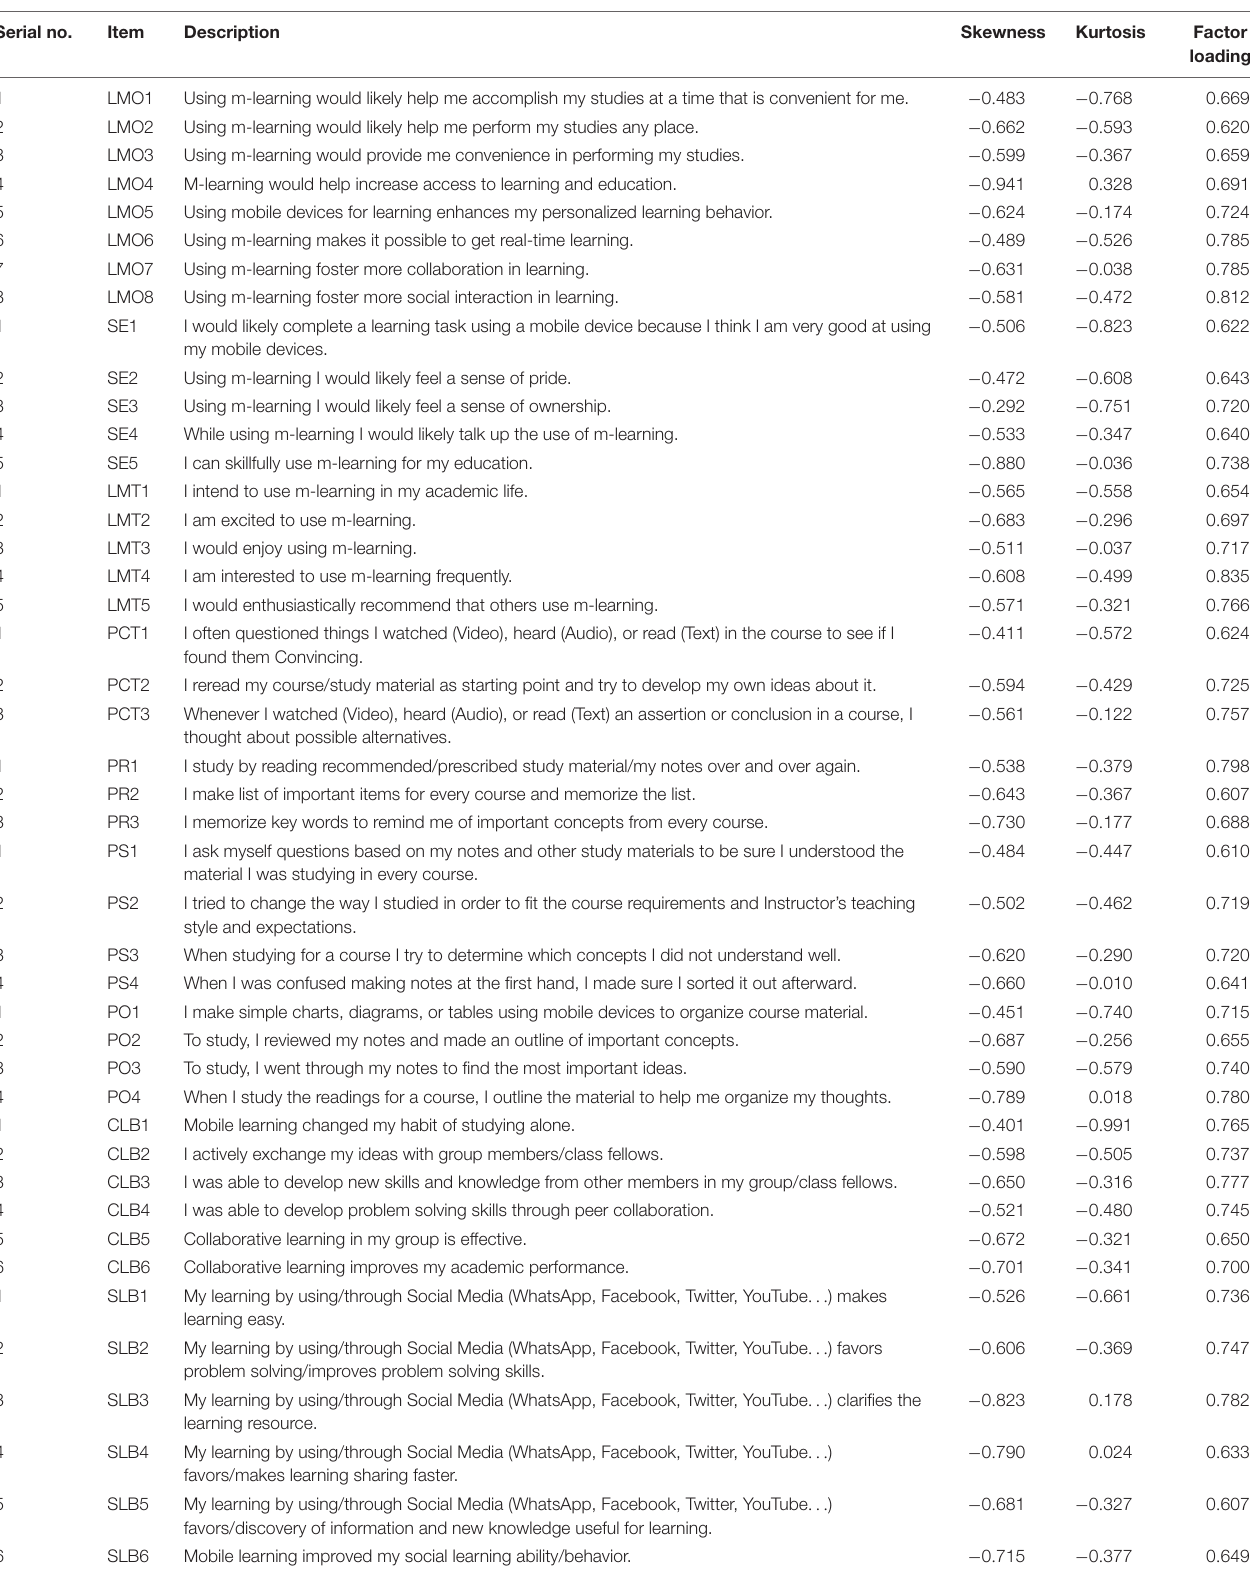
TABLE 1 | Skewness, kurtosis, and factor loading. Serial